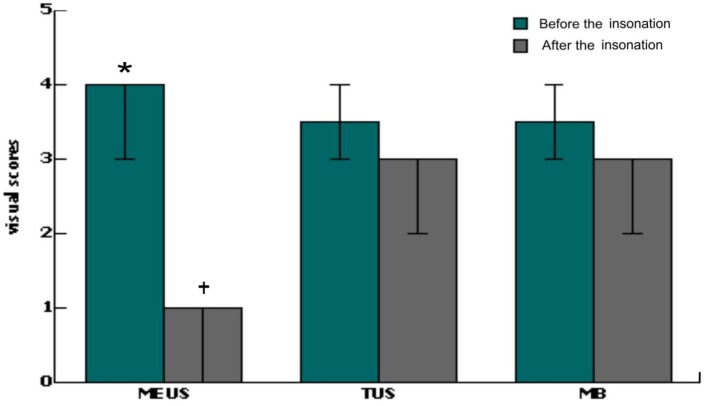
A comparison of bleeding visual scores before and after insonation.*P<0.05 indicates a significant difference between before and after insonation of MEUS group. +P<0.05 indicates a significant difference between MEUS group and the controls.